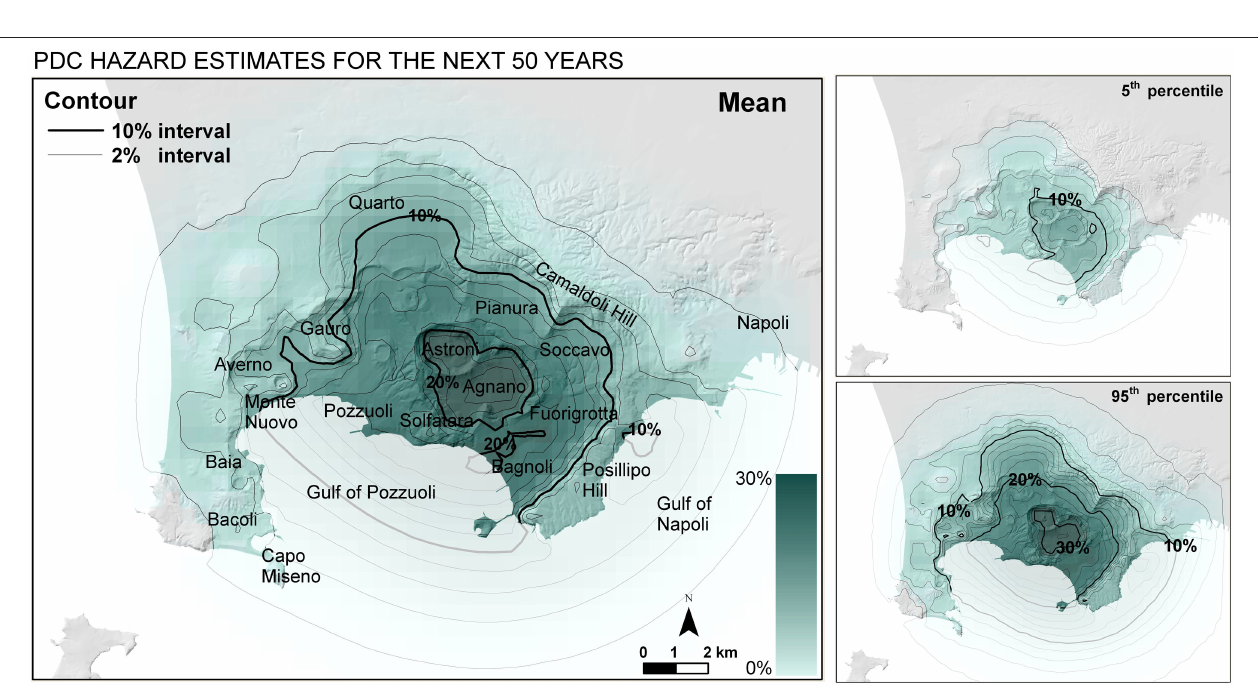
Frontiers in Earth Science | www.frontiersin.org